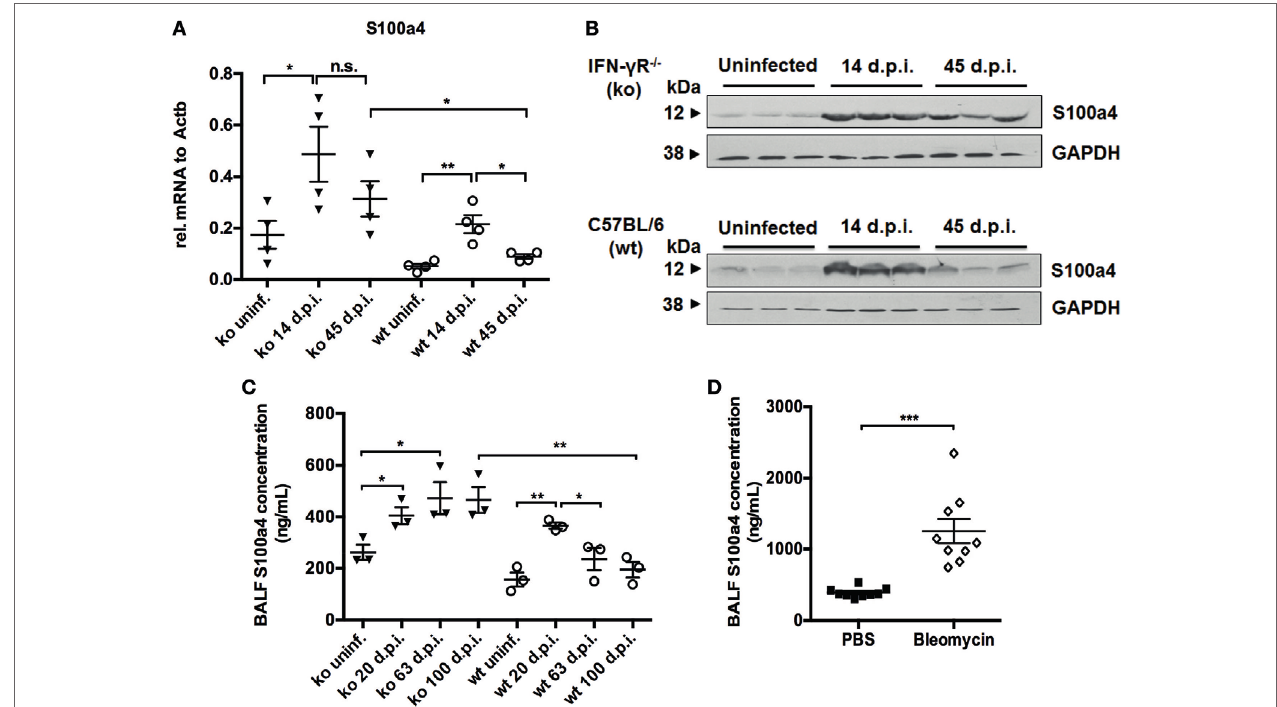
FigUre 1 | Analysis of S100a4 expression in two different mouse models of pulmonary fibrosis. (a) RNA was isolated from uninfected and from MHV-68- infected IFN- γ R − / − (ko) and C57BL/6 wild-type (wt) mice at days 14 and 45 after infection. S100a4 expression was analyzed by qRT-PCR, normalized to the expression of β -actin, and depicted as relative fold changes. Results are derived from three mice per group and shown as mean ± SD. (B) Lung homogenates from uninfected mice and MHV-68-infected mice at the indicated time points were subjected to western blot analysis for the S100a4 protein (three mice per group). Blots were either incubated with an anti-S100a4-antibody or an anti-GAPDH antibody as loading control. (c) S100a4 protein was measured in bronchoalveolar lavage (BAL) fluids from uninfected or MHV-68-infected IFN- γ R − / − (ko) and C57BL/6 mice (wt) at days 20, 63, and 100 after infection. Each symbol represents a mouse. Results are derived from three mice per group and shown as mean ± SD. Unpaired t -test was performed for statistical analysis (* denotes p < 0.05; ** denotes p < 0.01; n.s. denotes non-significance). (D) Protein levels of S100a4 were measured in BAL fluid from PBS or bleomycin-treated C57BL/6 mice at 14 days after instillation. Each symbol represents a mouse. Results are derived from nine mice per group and shown as mean ± SD. Unpaired t -test was performed for statistical analysis (*** denotes p < 0.001).